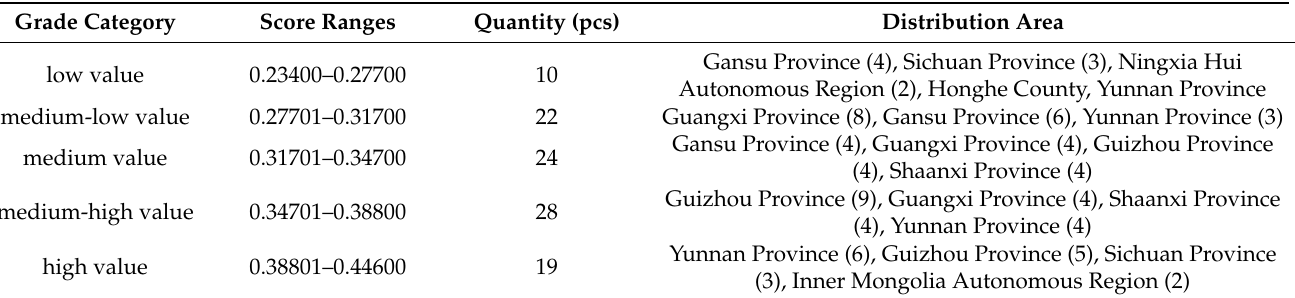
Figure 2. Classification result of CSDC comprehensive score of key counties to receive assistance. Table 3. Classification result of the sustainable development capacity comprehensive score of key counties to receive